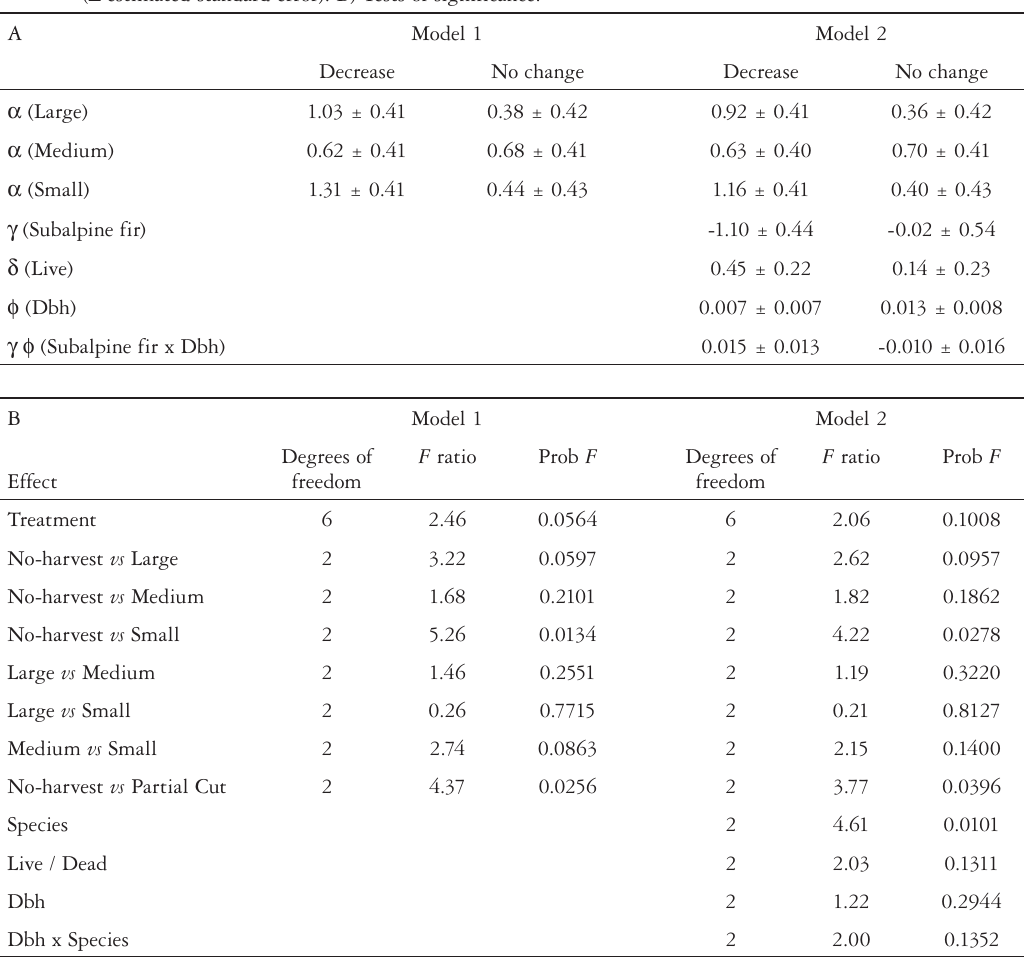
Table 5 Logistic regression models for the change in lichen composition (% Alectoria ) from 1993 to 2003, including fallen and recruited sample trees. The reference value in the analysis is the increase. A) Parameter estimates ( ± estimated standard error). B) Tests of